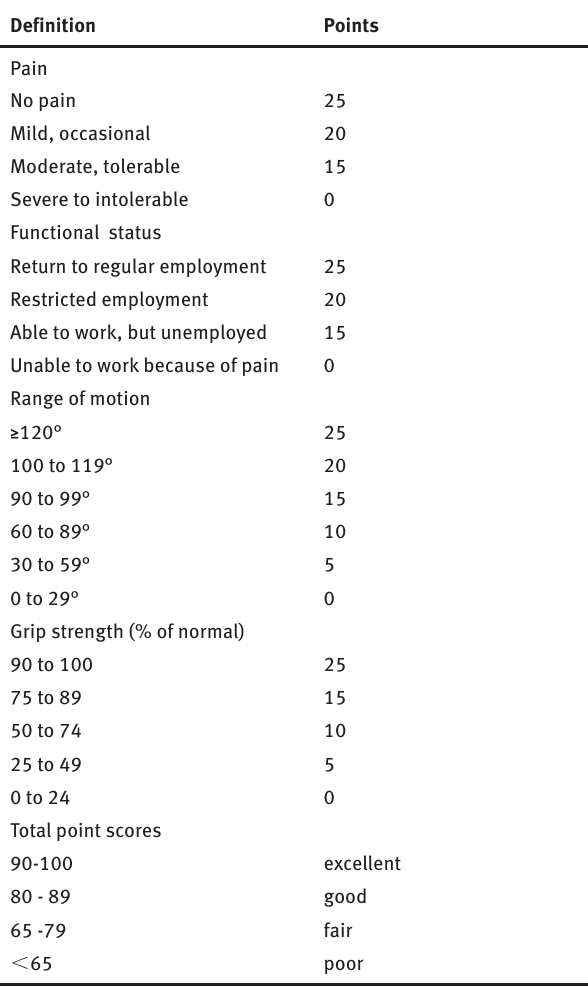
Table 1: Mayo Modified Wrist Score.